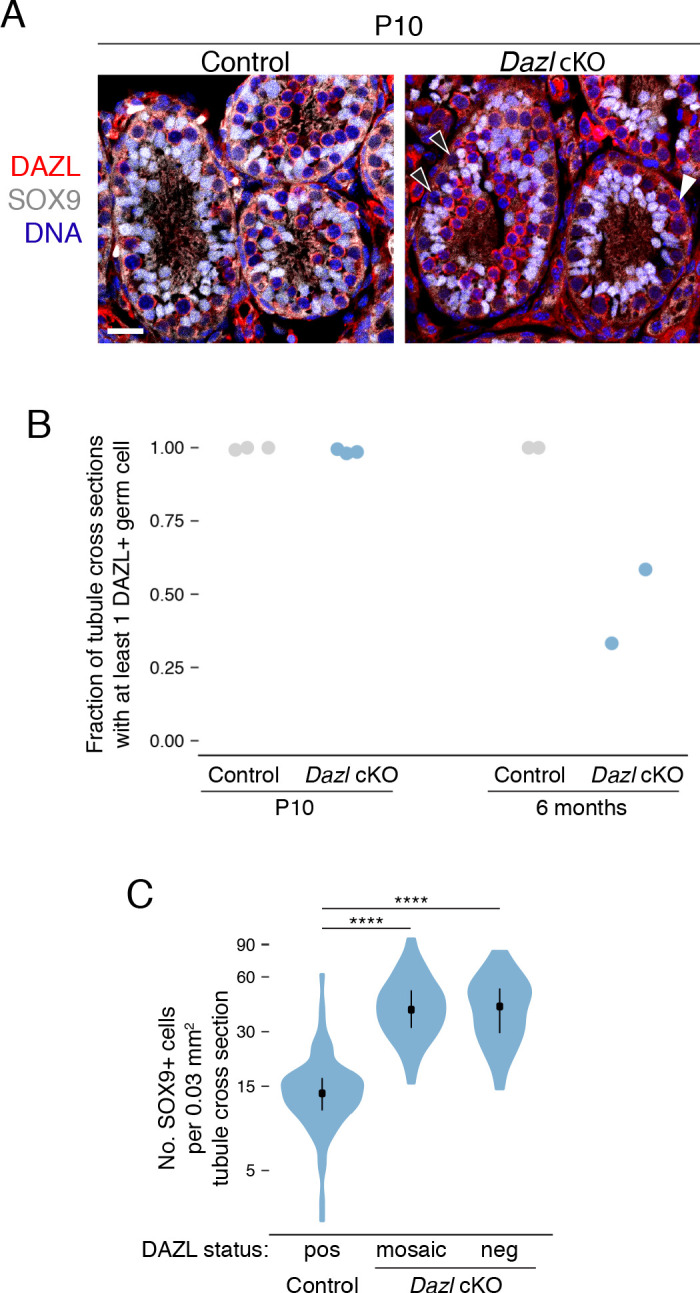
Conditional deletion of Dazl in spermatogonia.(A) DAZL protein staining (red) in control and Dazl cKO P10 testes. SOX9 marks Sertoli cells (gray) and DAPI marks DNA (blue). DAZL-positive and -negative germ cells marked by white and black arrowheads, respectively. Scale bar = 20 μm. (B) Percentage of seminiferous tubule cross sections exhibiting at least one DAZL+ germ cell at postnatal day 10 (P10) and at 6 months. Each data point represents quantification from a single animal. At least 50 tubule cross sections were quantified per animal. (C) Quantification of SOX9-positive Sertoli cells per 0.03 mm2 area of seminiferous tubule cross section (two-sided Mann-Whitney U test). The area of the average tubule cross section analyzed in Figure 1C was 0.03 mm2. ****, p<0.0001.